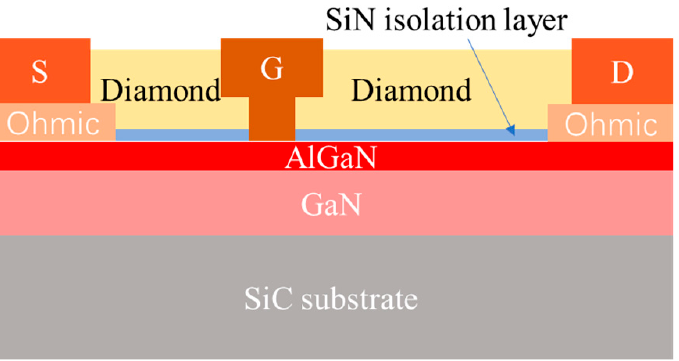
Figure 1. Schematic of the GaN HEMTs with the nanocrystalline diamond capping layers (NDC). The specific process of preparing NDC-GaN HEMTs was as follows. The device was carried out on a small piece with a size of 1 cm 2 . First, mesa isolation and ohmic metal were performed by conventional operations; the thickness of source and drain was 200